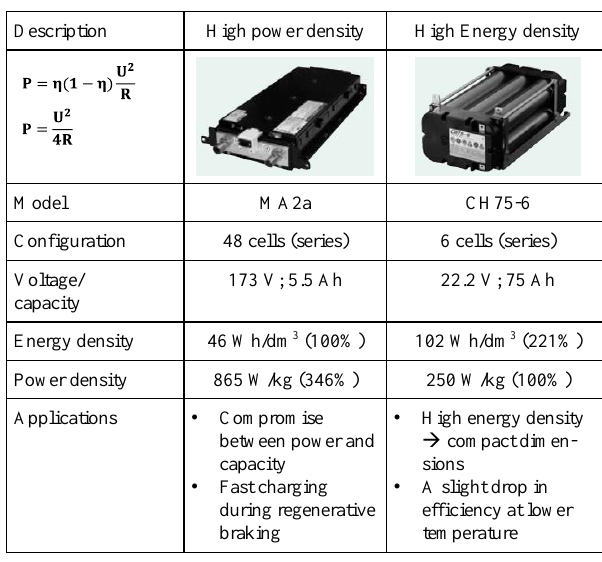
Table. 1. Battery configurations in applications for hybrid drive of rail vehicles [18]